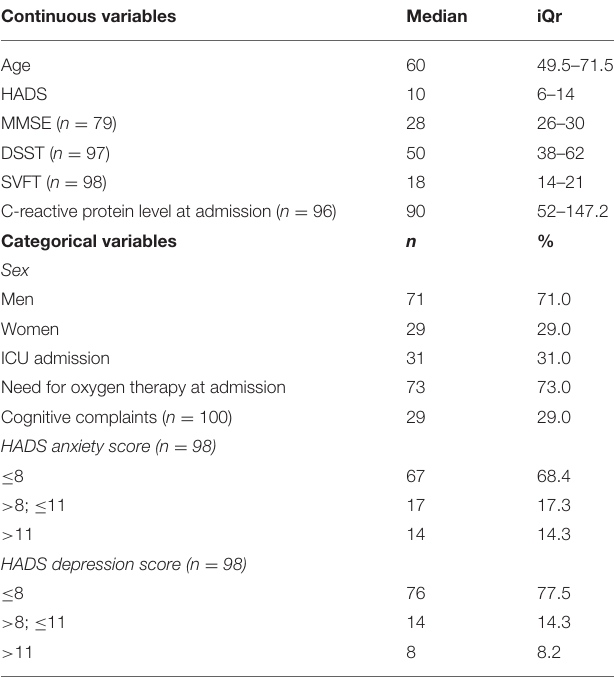
TABLE 1 | Participants characteristics ( n =